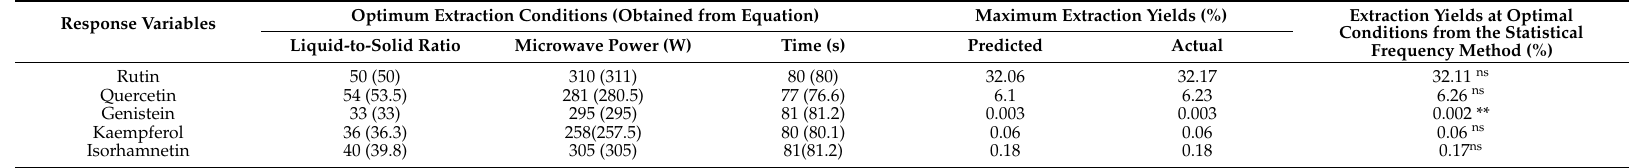
Table 4. Estimated optimum conditions, predicted and experimental values of responses under these conditions.